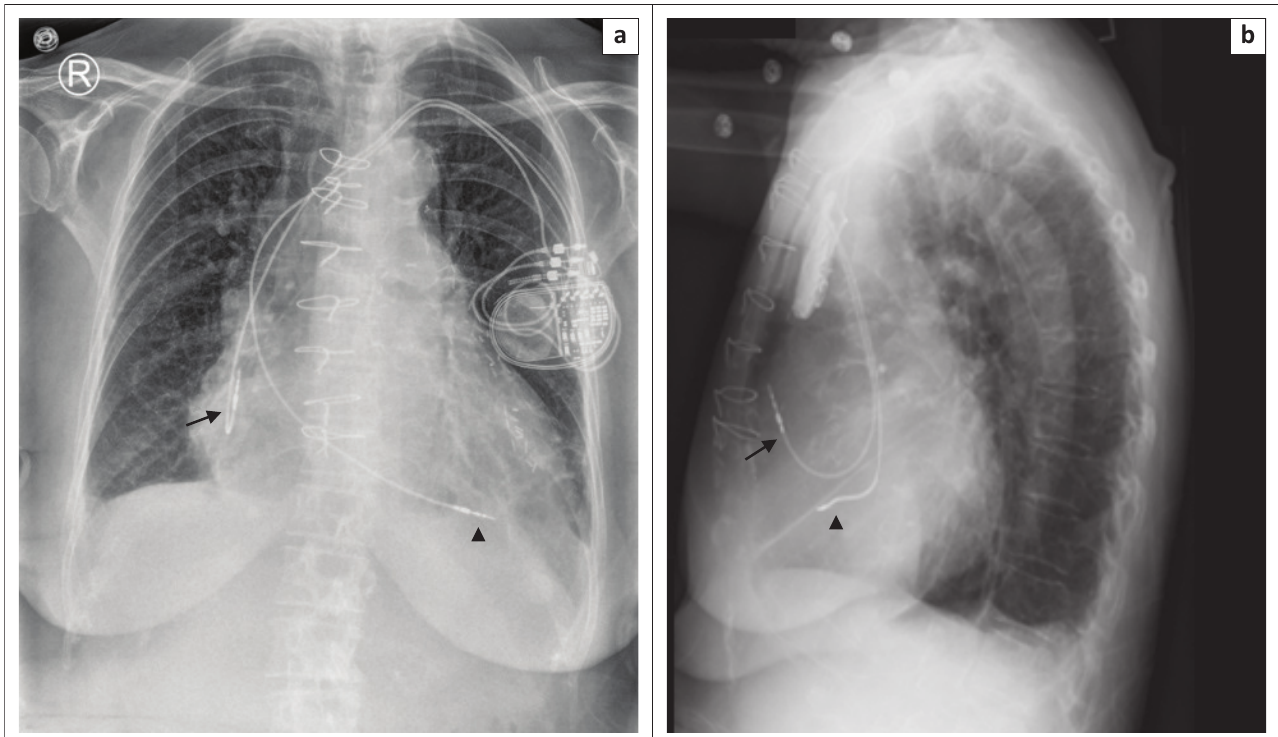
FIGURE 2: Frontal (a) and lateral (b) view chest radiographs showing a dual-chamber pacemaker with the right atrial lead (arrow) in the right atrial appendage forming a ‘J’ on the lateral view and the right ventricular lead (arrow head) pointing towards the cardiac apex.